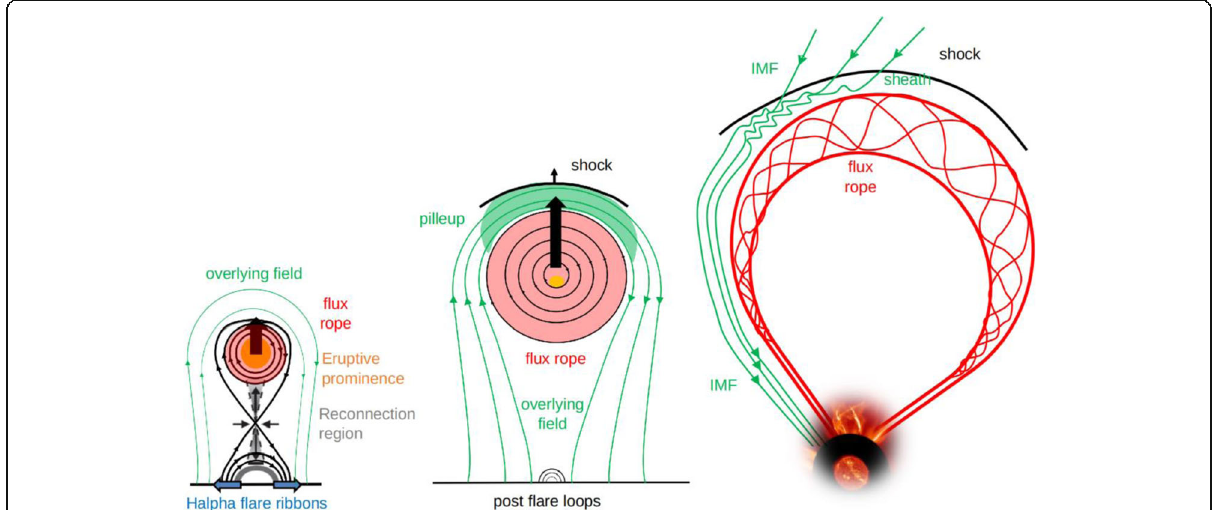
Fig. 9 Cartoon describing three different stages of CME evolution based on “ the standard CME-flare model ” and “ the standard magnetic cloud model ” : the onset (left), post-eruption phase (middle), and interplanetary propagation